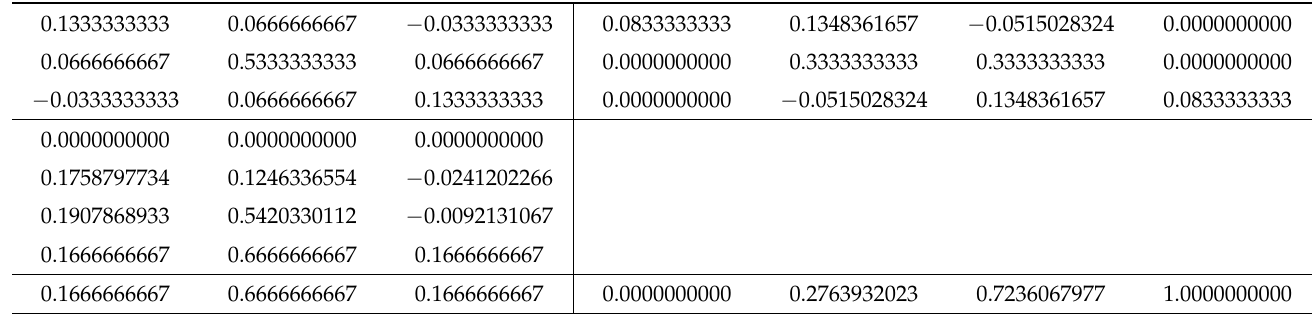
Table A20. L3|L4 method.